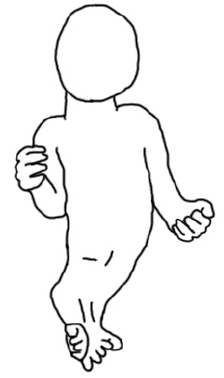
Figure 1. Sirenomelia. Figure 1.